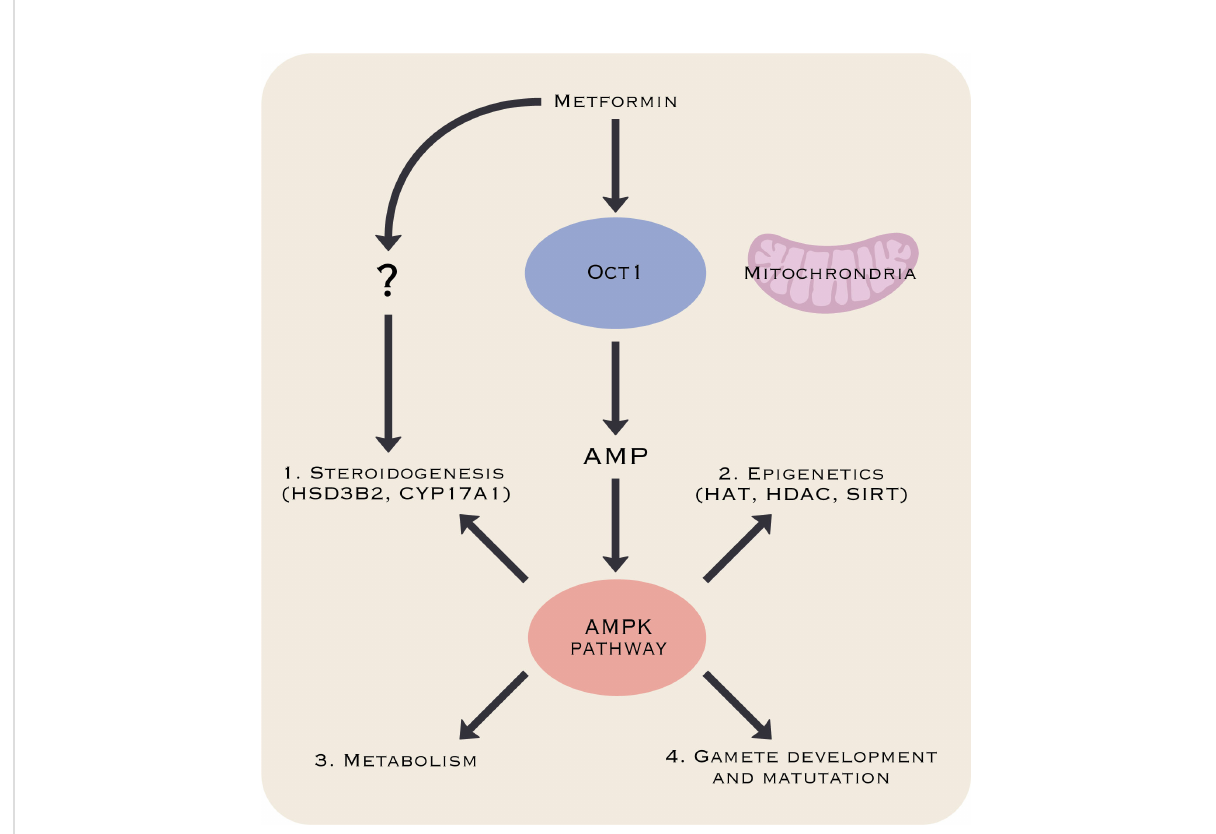
FIGURE 2 Metformin ’ s processes of potential interference with fetal development. Metformin may interfere with fetal development through effects on steroidogenesis (38), epigenetics (39), metabolism (40), and gamete development and maturation (27). The mechanism behind these effects remains poorly understood, but data suggest that the AMP-induced protein kinase (AMPK) pathway might play a central role except for effects on steroidogenesis that might be AMPK-independent